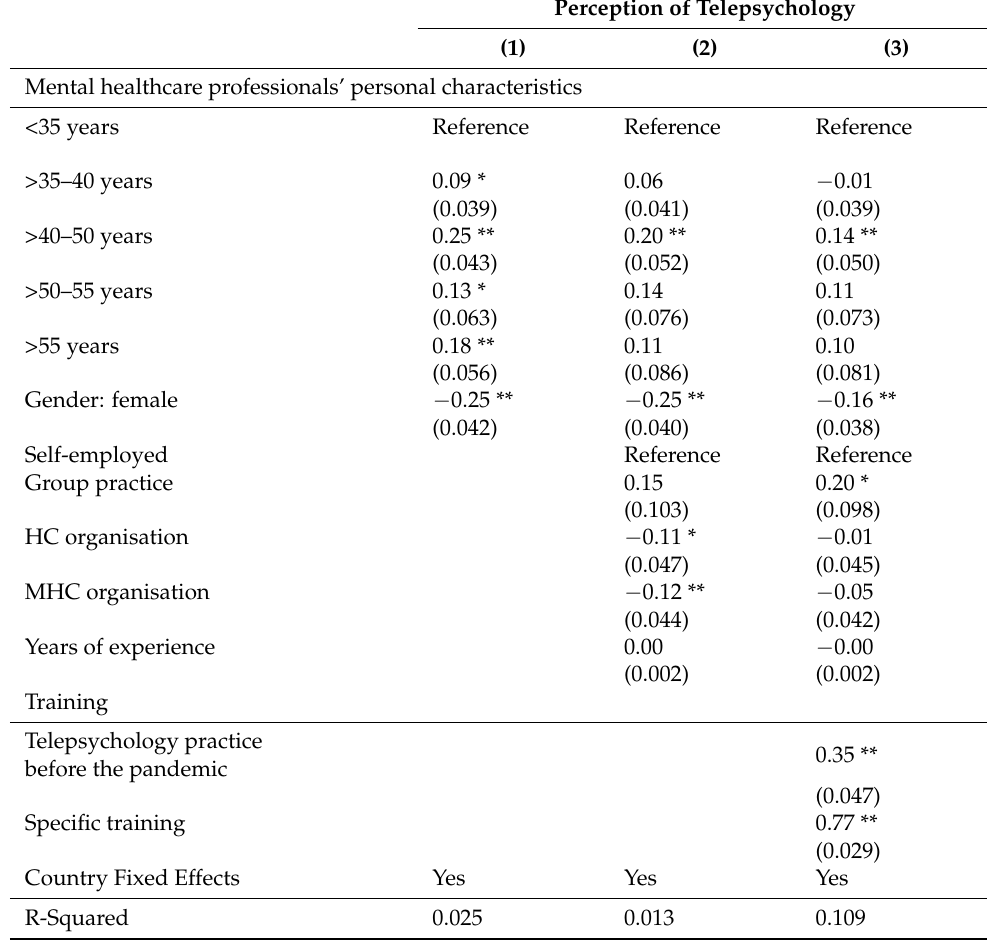
Table 2. Econometric model predicting the perception of telepsychology among European mental healthcare